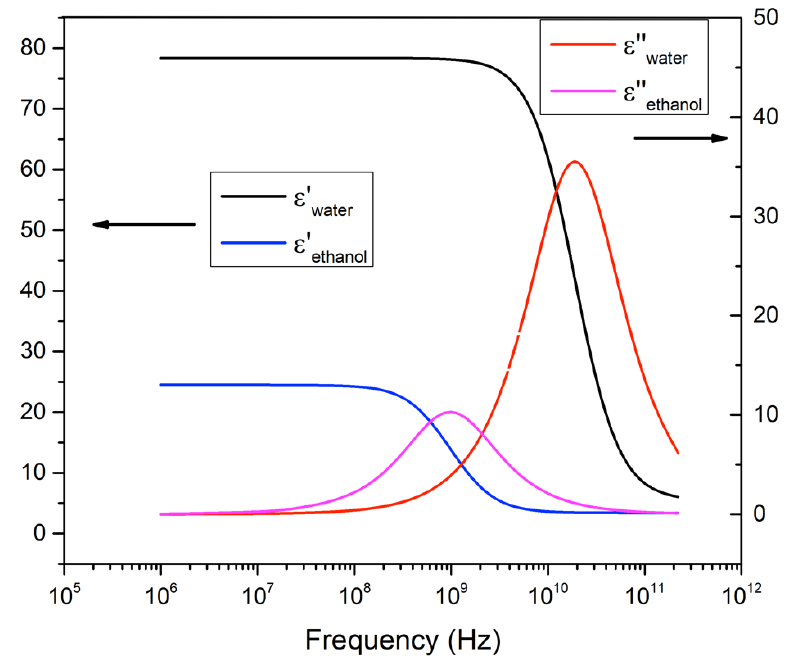
Figure 1. Real ( ε (cid:48) ) and imaginary ( ε (cid:48)(cid:48) ) components of water and ethanol permittivity as a function of Figure 1. Real (ε’) and imaginary (ε’’) components of water and ethanol permittivity as a function frequency at 25 ◦ C. ε and ε (cid:48)(cid:48) values are reported on different vertical scales for better visibility. The of frequency at 25 °C. ε and ε’’ values are reported on different vertical scales for better visibility. curves are Debye functions defined by the parameters reported in The curves are Debye functions defined by the parameters reported in [16].